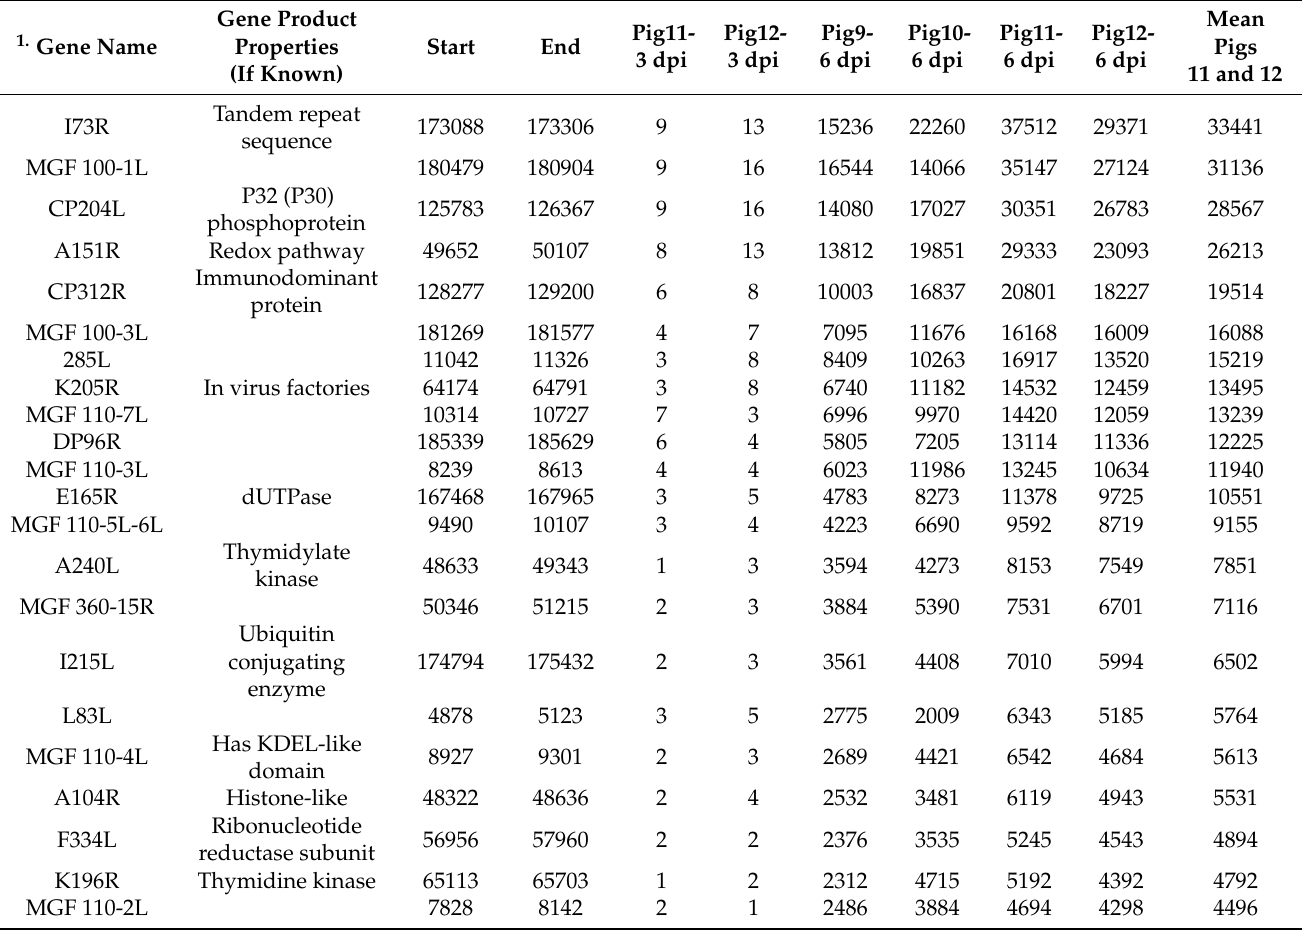
Table 5. Most highly expressed ASFV genes (>180 nt) following